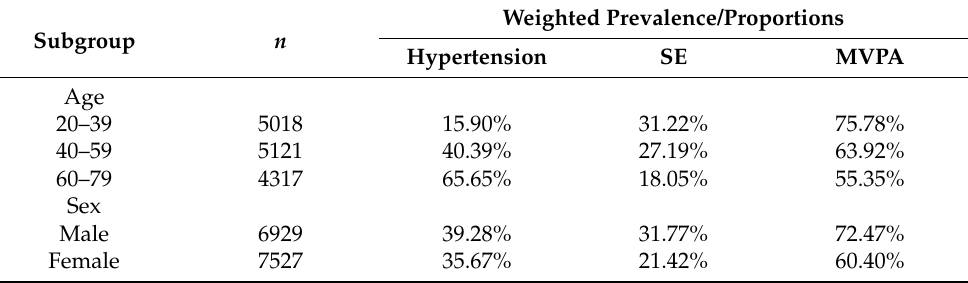
Figure 3. The results of stratification analyses by age and sex. ( A ) Associations between SE and hypertension stratified by age and sex ( n = 14,456). ( B ) Associations between MVPA and hypertension stratified by age and sex ( n = 14,456). Models were adjusted for age, sex, race, education level, marital status, family PIR, survey wave, and another exposure assessment. Abbreviations same as in Figure 2. Table 2. Weighted prevalence of hypertension, and proportions of SE participants and MVPA participants among the different